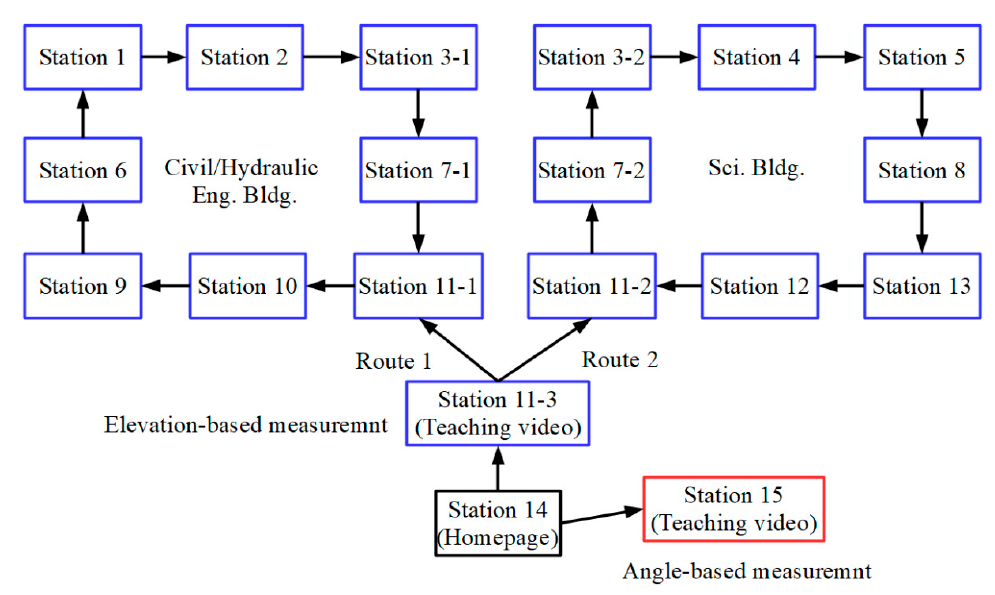
Figure 8. Webpage framework and panoramic stations, where blue and red colors represent elevation- and angle-based measurements.